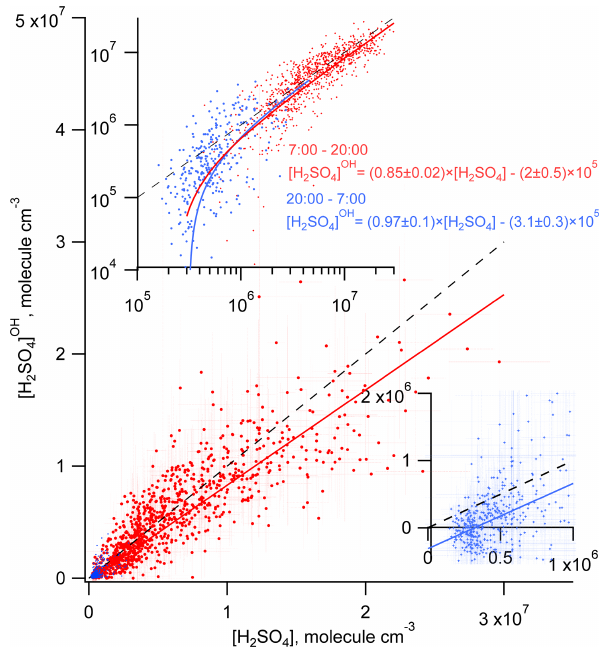
Figure 3. Comparison of the measured H 2 SO 4 and the H 2 SO OH calculated accounting only for the OH + SO 2 source during the day (red) and during the night (blue). Solid lines correspond to linear regression fitting accounting for both X and Y measurement uncer- tainties. Dashed lines represent 1:1 ratios. Inserts, log plot (upper) and linear plot (lower right) are added for clearer presentation of the nighttime